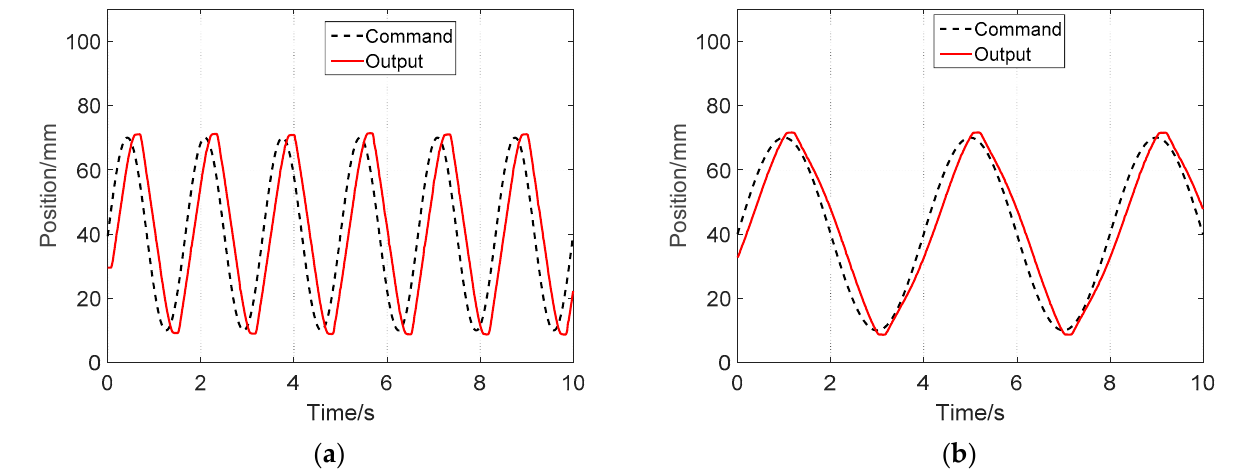
Figure 29. The experimental results in sine control using the delay compensation control method after the controller parameters are modified. ( a ) k f = 250 with 0.63 Hz. ( b ) k f = 125 with 0.25